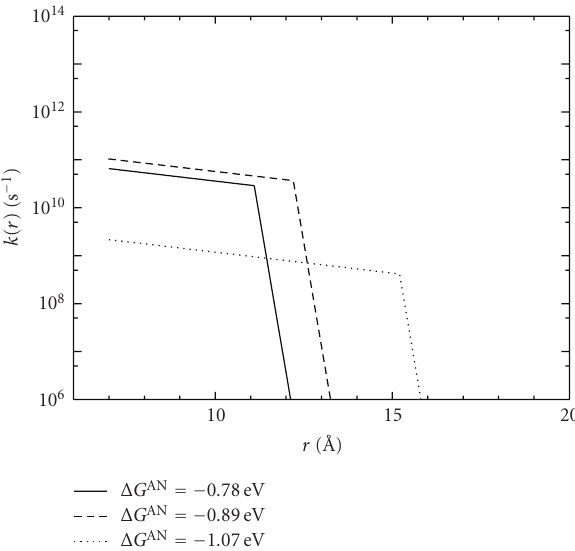
Figure 7: First-order ET rate of the three D-A pairs obtained from R 0 , k 0 , (18) and (19). The Δ G AN values correspond to the D-A pairs given in Table